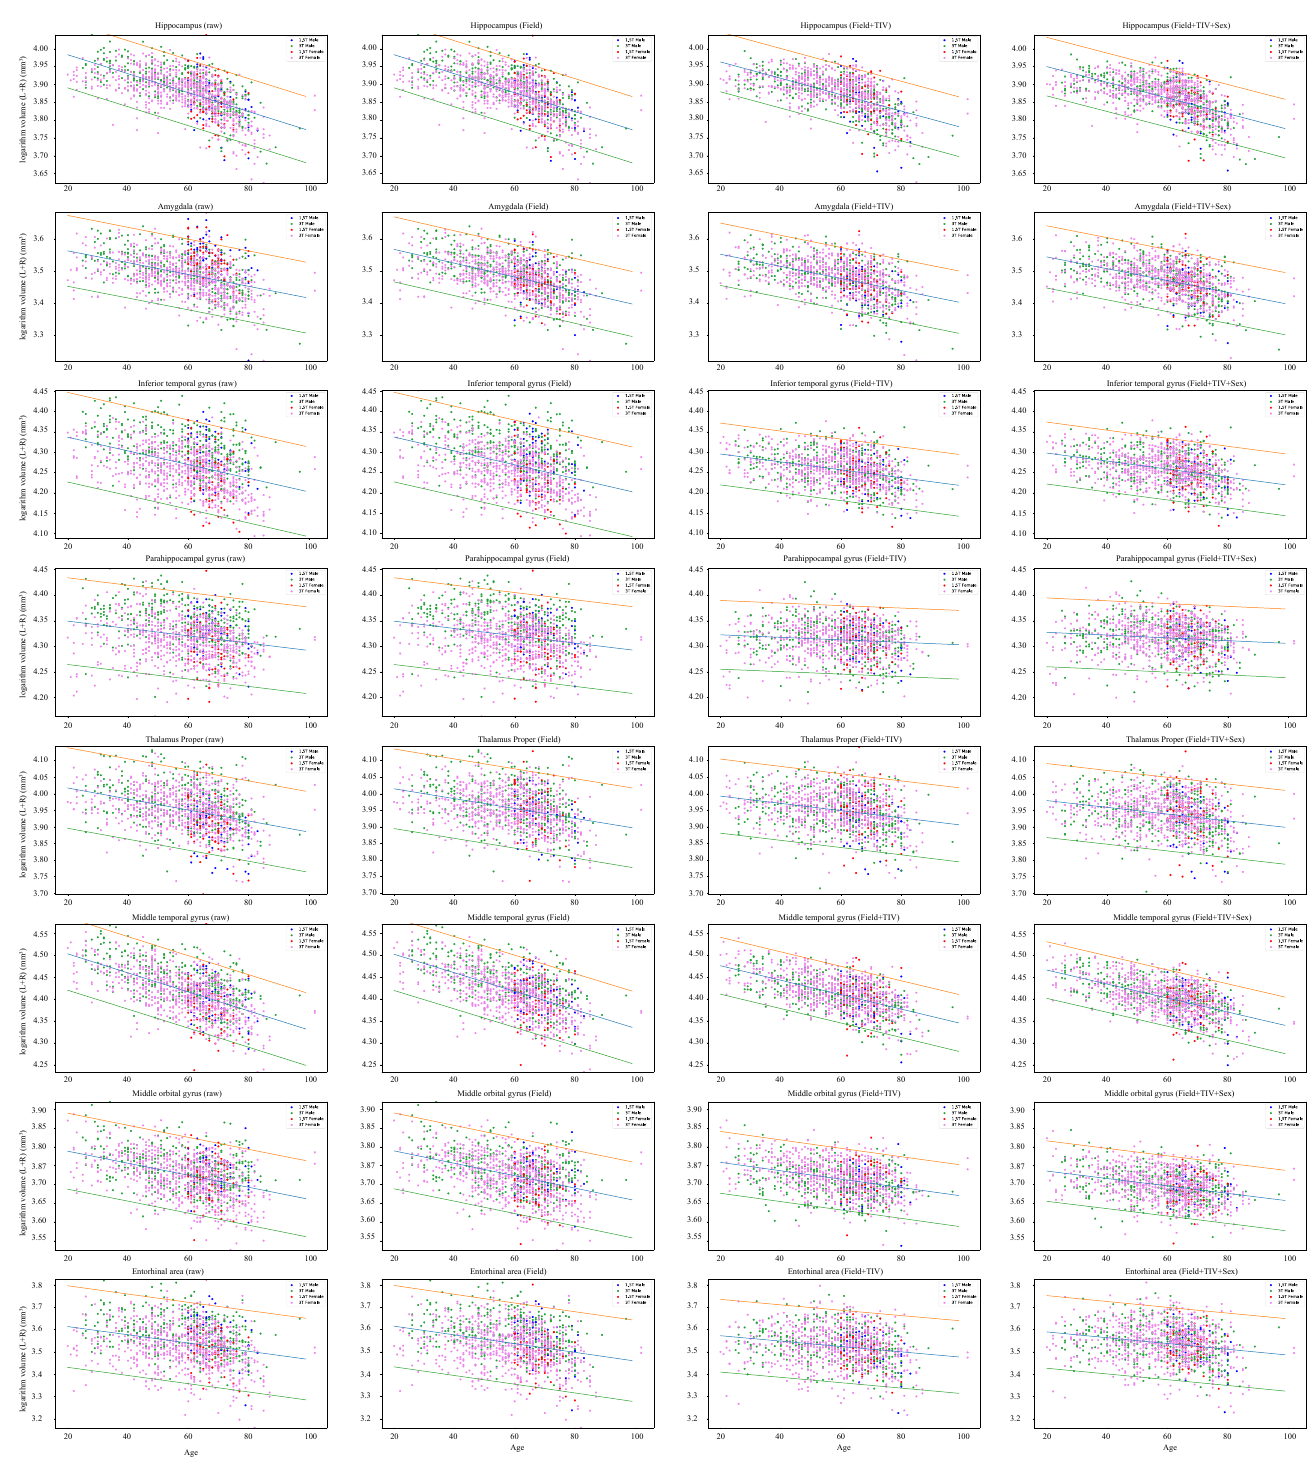
Figure 1. Correlation between age and some selected